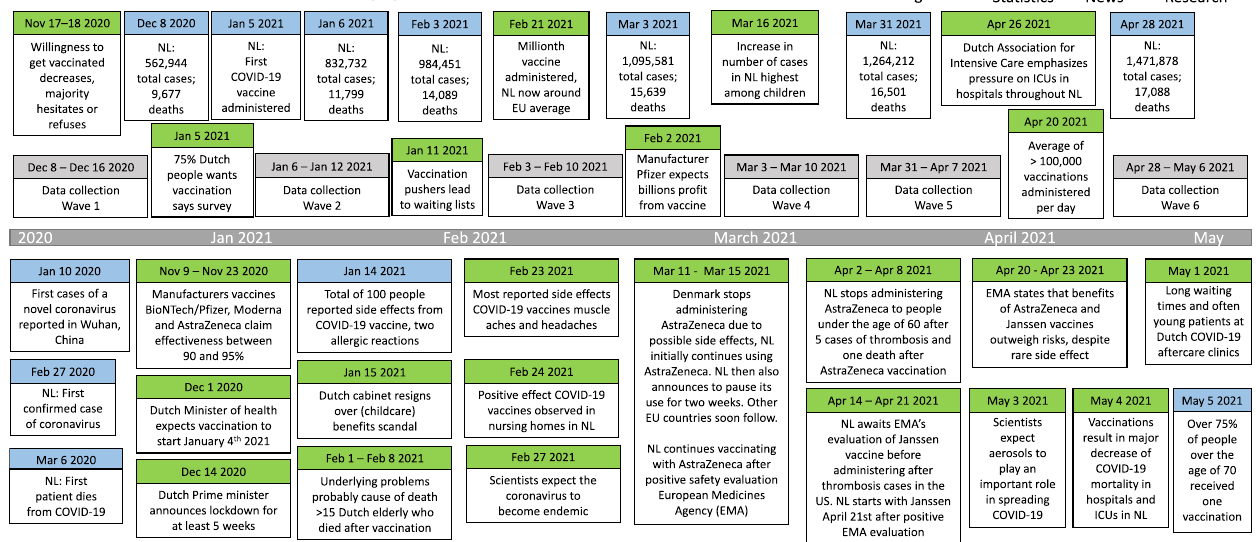
Fig. 2 Dutch COVID-19 vaccines timeline. Timeline of Dutch media coverage on COVID-19 vaccines and the pandemic ’ s trajectory in the